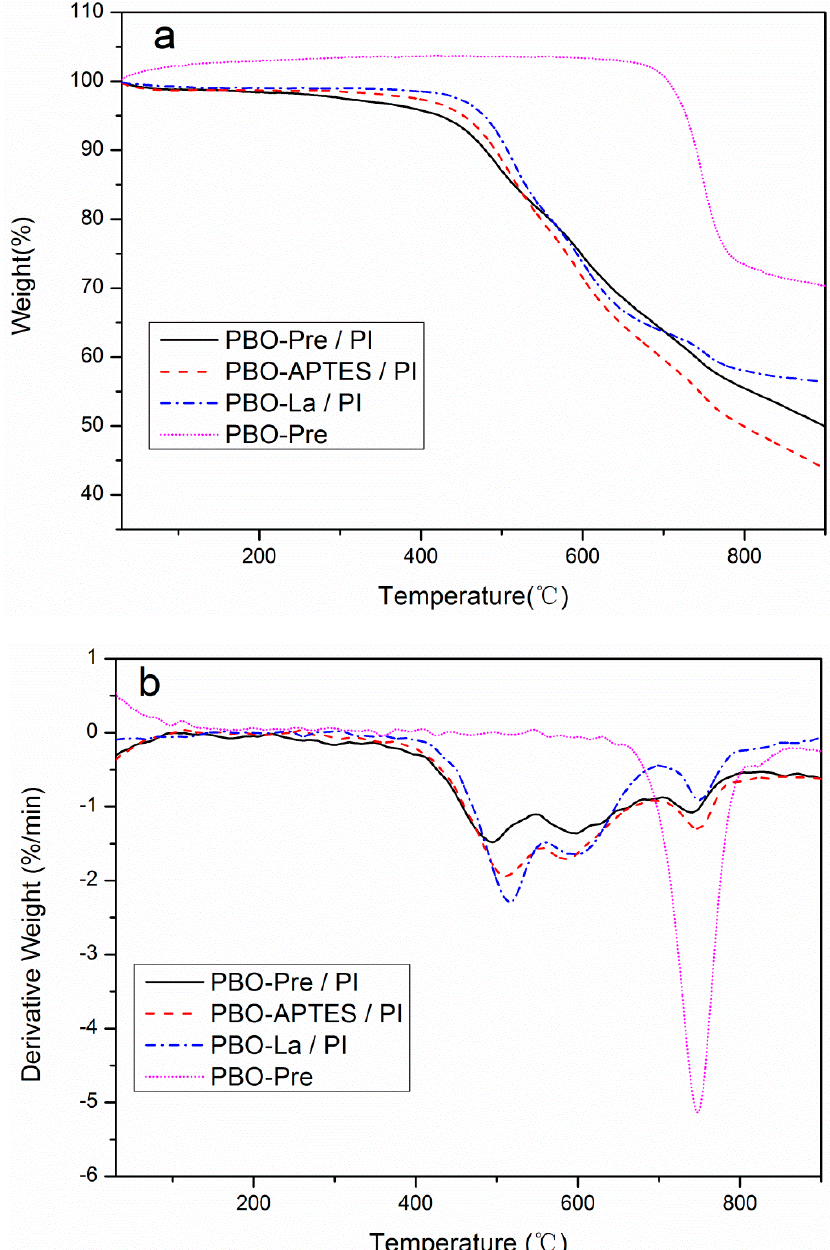
Figure 8. ( a ) TGA, ( b ) DTG of the PBO-Pre fiber and PI composites.